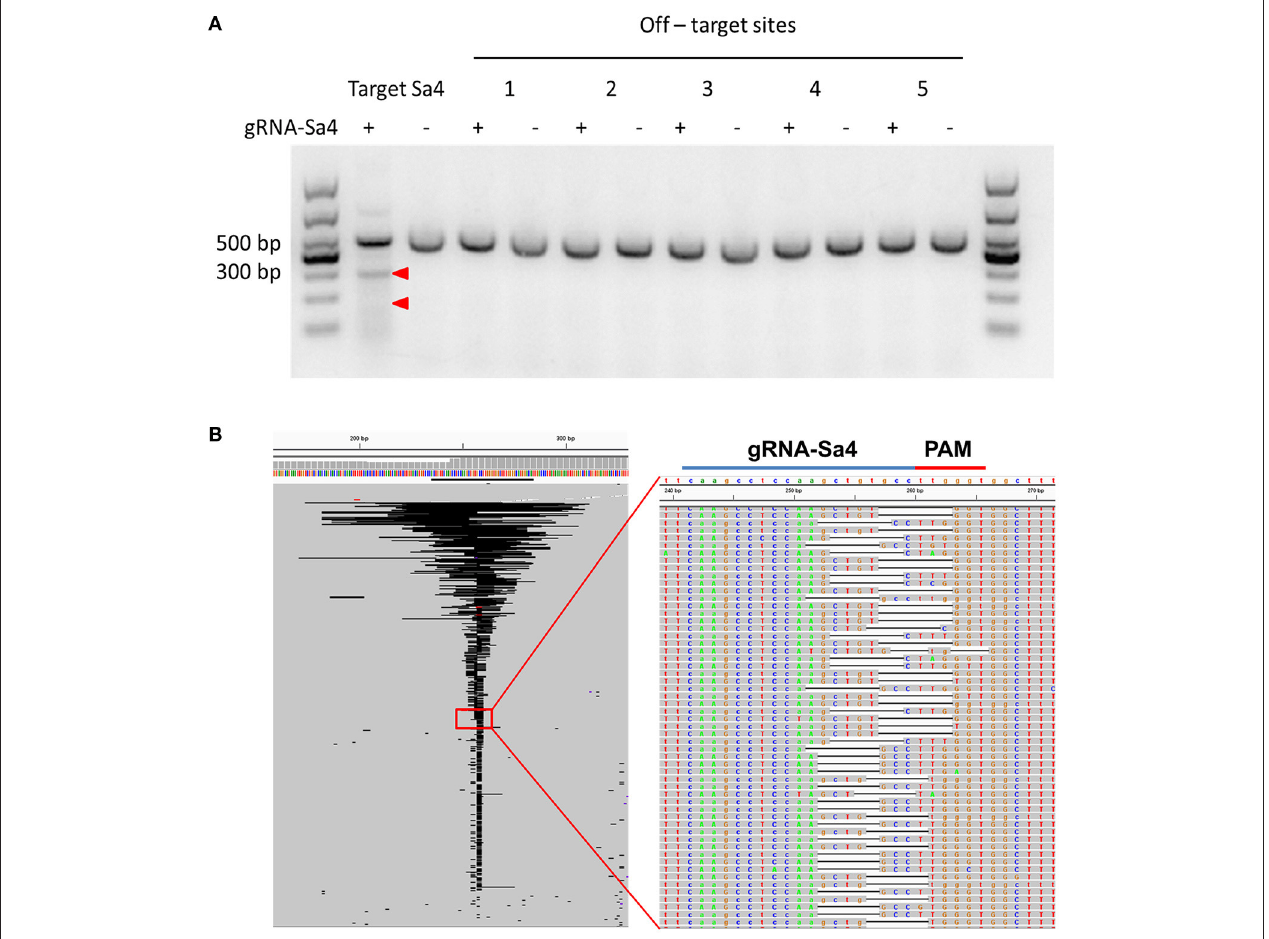
FIGURE 3 | rAAV8-mediated CRISPR-SaCas9 introduction disrupted HBV DNA in the liver of HBV-Tg mice. (A) Assessment of off-target cutting by gRNA-Sa4. The results of the surveyor assay in liver cells treated with gRNA-empty (–) and gRNA-Sa4 ( + ) are shown; gRNA-Sa4 and gRNA-Sa4 off-target sites 1, 2, 3, 4, and 5 were PCR-amplified. T7EI nuclease-cleaved gRNA PCR products are indicated by Red arrow heads. (B) Representative views of target S4 region deletion in gRNA-S4-treated mice, generated using Integrative Genomics Viewer. Black bars: deletions; gray bars: sequencing